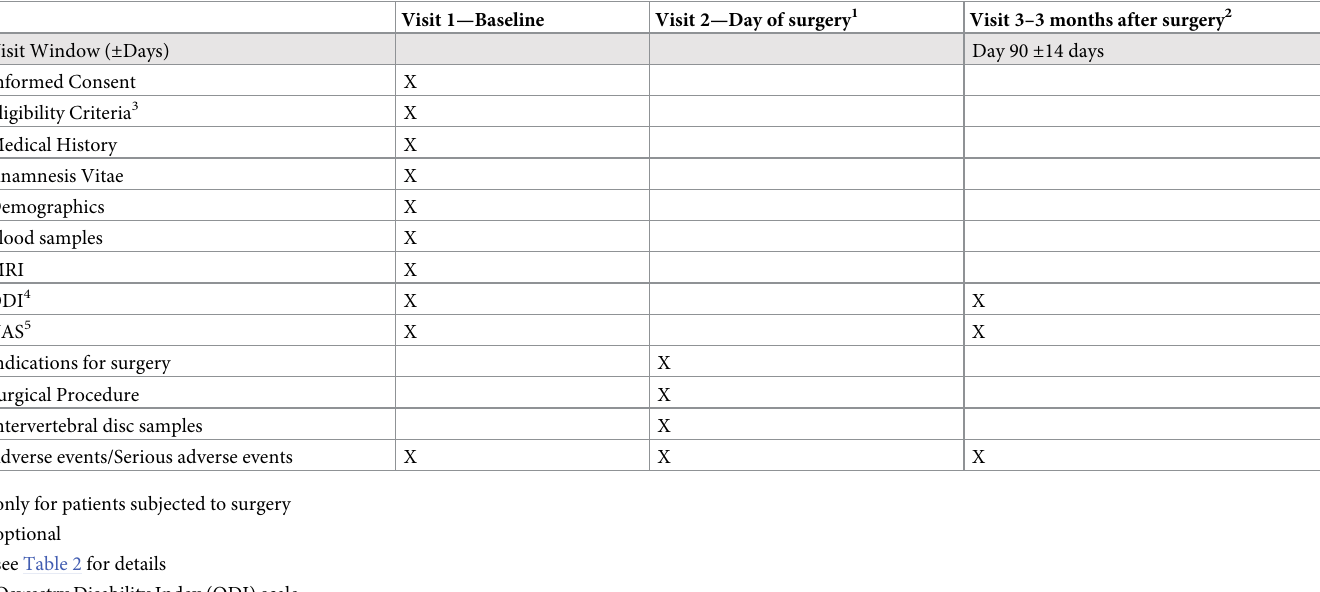
Table 1. Scheduled procedures for clinical data and sample